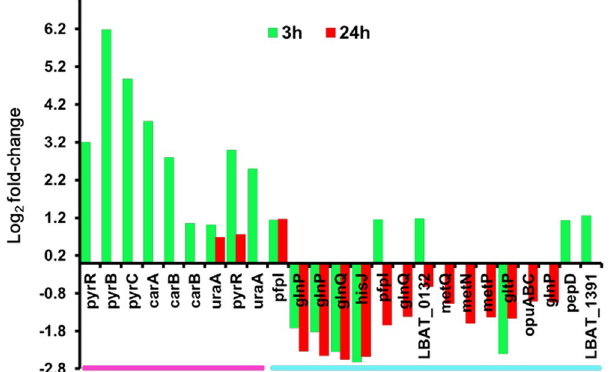
Figure 4. Log 2 fold-change value of genes related to nitrogen transport and metabolism induced by 12%(v/v) ethanol. Color code: pink: nucleotide transport and metabolism, cyan: amino acid transport and metabolism. 3 h: 3 hours after exposing to ethanol, 24 h: 24 hours after exposing to